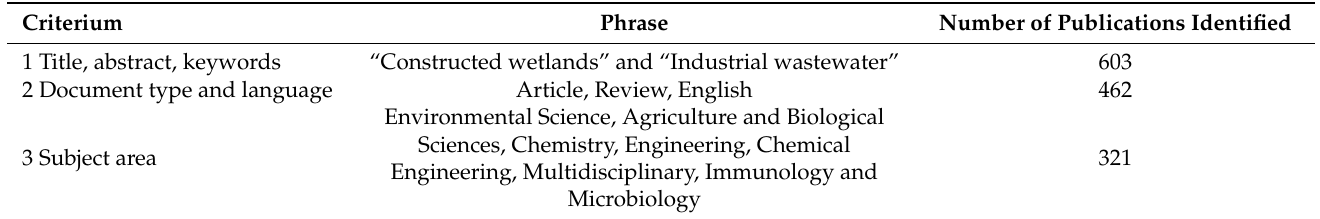
Table 1. Criteria and results of filtering scientific publications in the Scopus